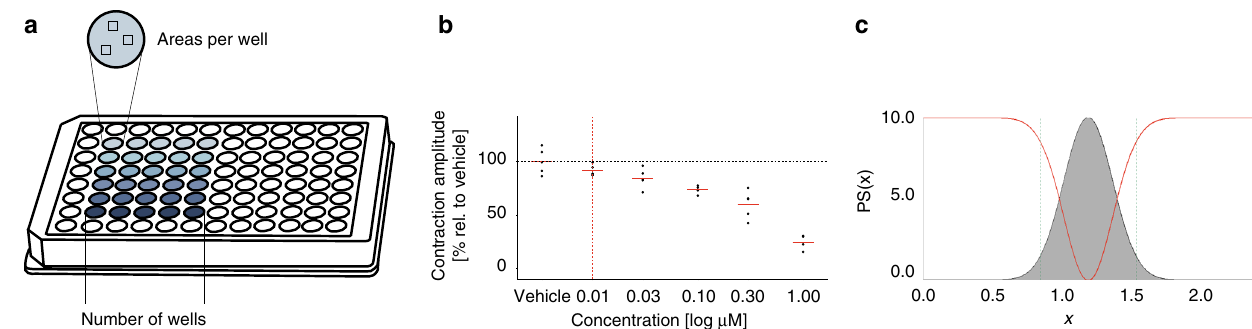
Fig. 2 Experimental setup and example output. a Schematic layout of the experimental setup; b output example of contraction amplitude in a concentration-response plot in which individual points show averaged values of a well and the red dotted line indicates the known therapeutic concentration; c corresponding probability density function (grey) and PS ↑ and PS ↓ (red lines) describing the three spaces for the three Probability